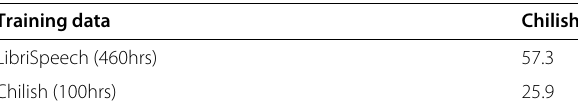
Table 1 TER% results on pure Chilish test set of